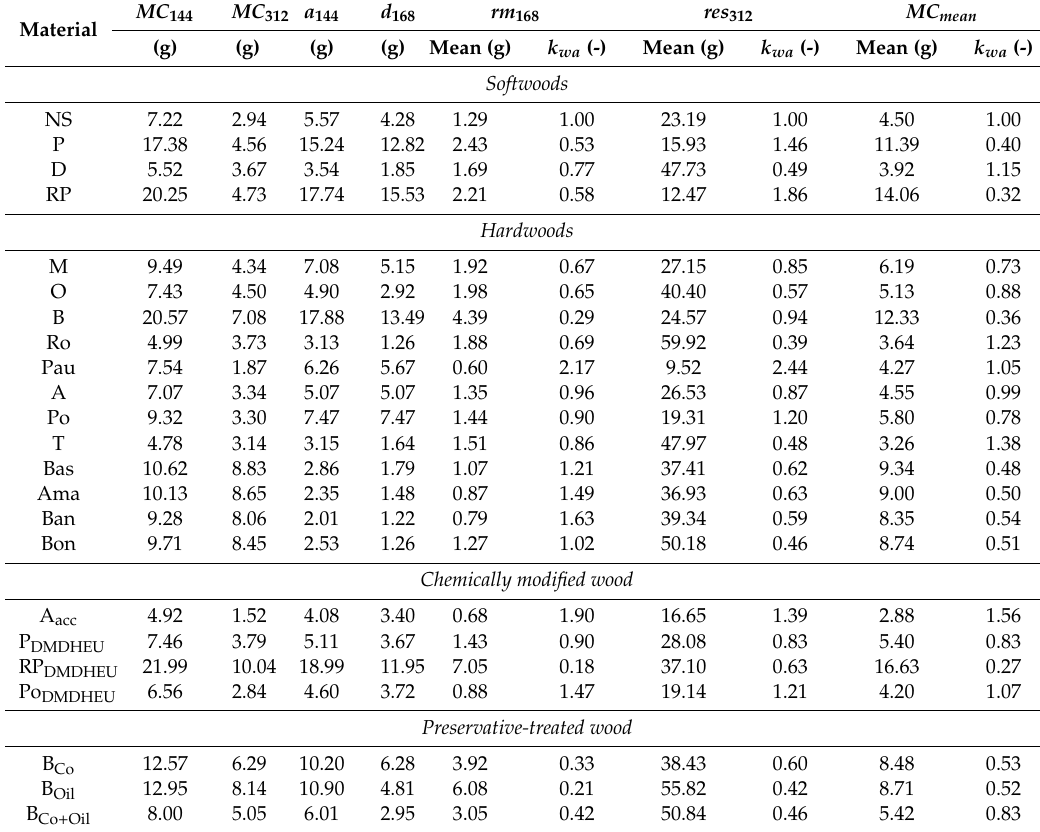
Table 2. Moisture content at the end of absorption ( MC 144 in g) and desorption cycle ( MC 312 in g), amount of absorbed moisture after 144 h ( a 144 in g), amount of desorbed moisture after 168 h ( d 312 in g), residual moisture content ( rm 168 in g), residue ( res 312 in g) and mean MC ( MC mean ) in floating tests (50 (ax.) × 50 × 25 mm 3 ) according to